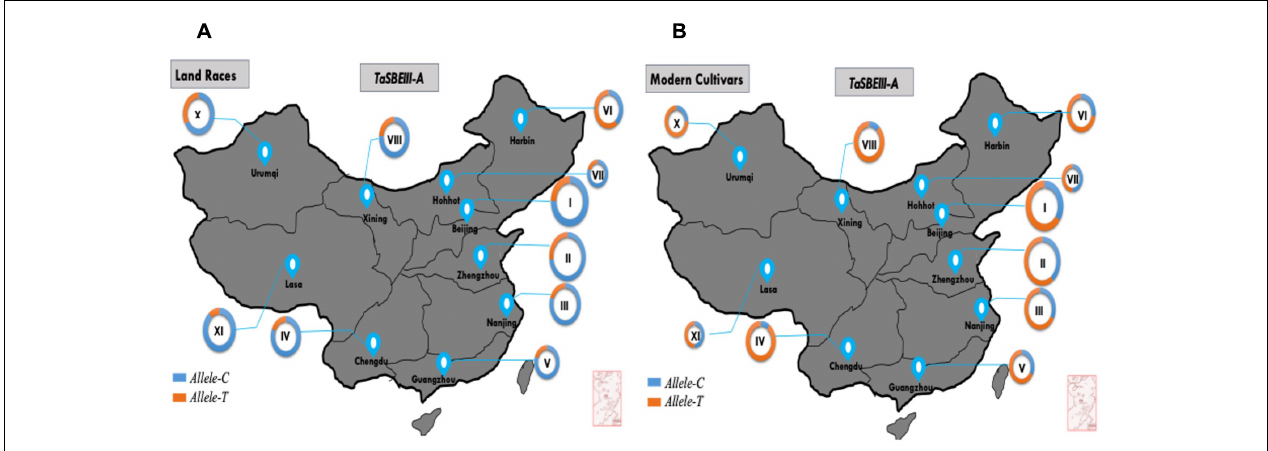
FIGURE 5 | TaSBEIII-A alleles. Geographic distribution in China. (A) Landraces, (B) modern cultivars. I, Northern winter wheat zone; II, Yellow, and Huai River valleys winter wheat zone; III, Middle and low Yangtze valleys winter wheat zone; IV, Southwestern winter wheat zone; V, Southern winter wheat zone; VI, Northeastern spring wheat zone; VII, Northern spring wheat zone; VIII, Northwestern spring wheat zone; IX, Qinghai-Tibetan spring-winter wheat zone; X, Xinjiang winter-spring wheat zone. Pie chart size is directly proportional to the number of genotypes.